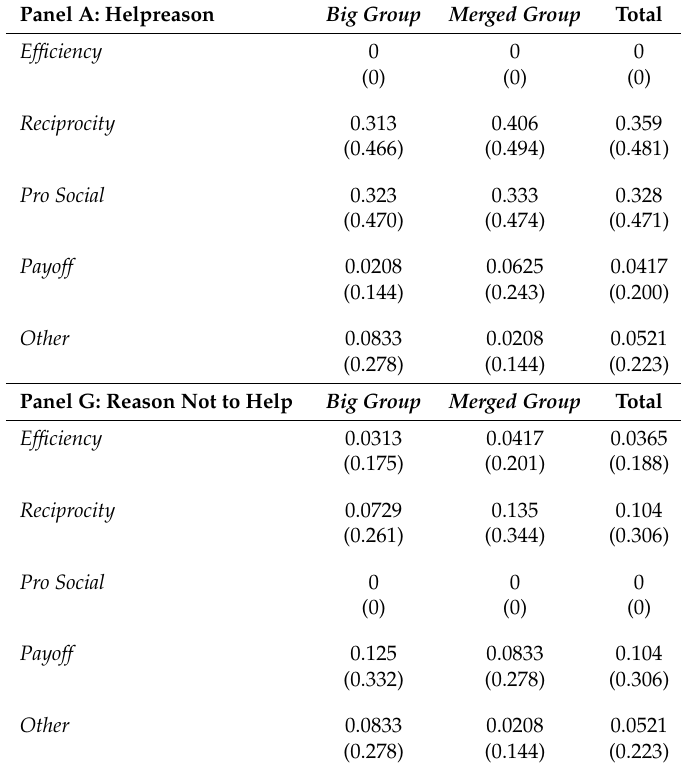
Table A13. Summary statistics: reason to help or not to help—questionnaire answers. Panel A: